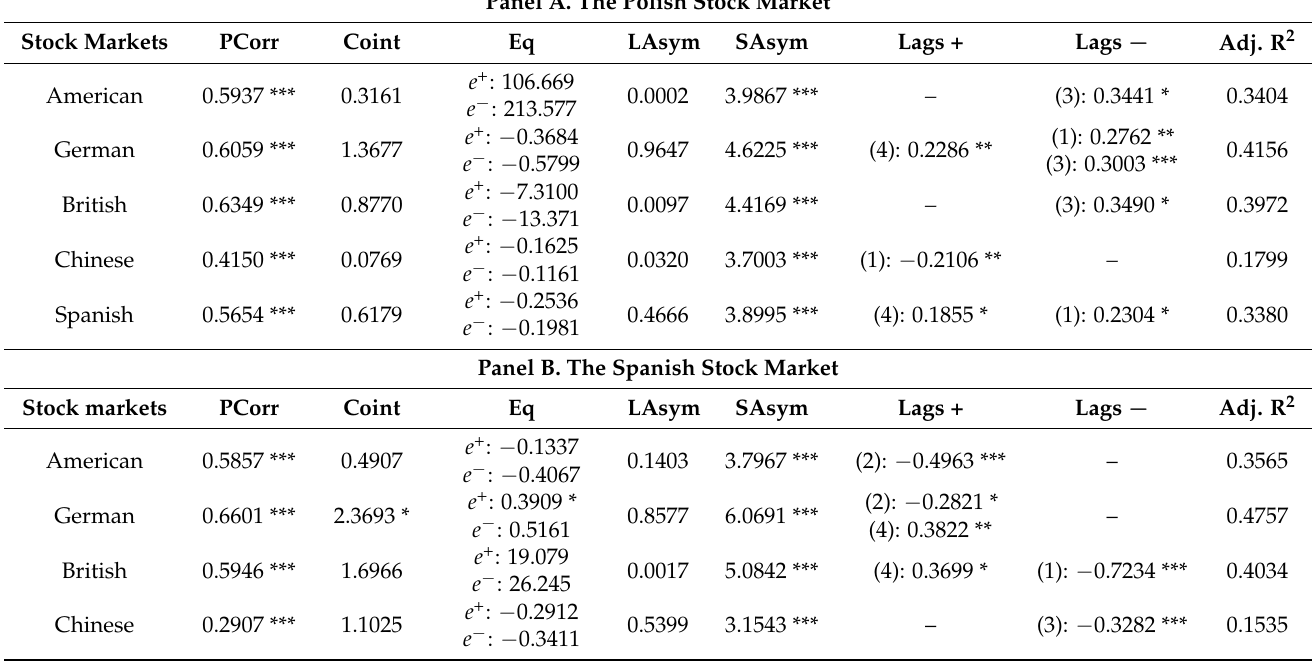
Table 7. Regression results of non-linear ARDL models: asymmetry and cointegration tests between the Polish (Panel A) and Spanish (Panel B) stock market and international (the American, German, British and Chinese) stock markets: